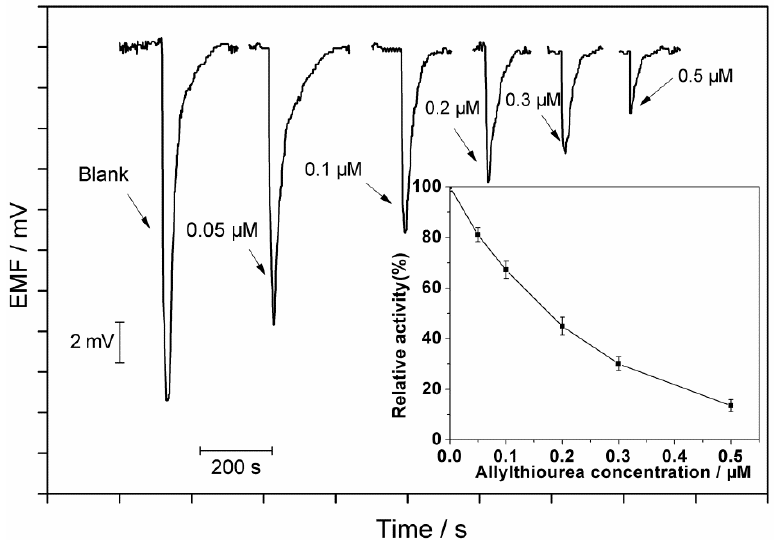
Figure 4. Potential responses of allylthiourea at different concentrations of 0.05, 0.1, 0.2, 0.3 and 0.5 μM. Inset shows the inhibition curve of allylthiourea (relative activity% = 100%–inhibition%). The amount of immobilized cells was 1.0 × 10 9 . The other conditions are given as in Figure 2. Each error bar represents one standard deviation for three